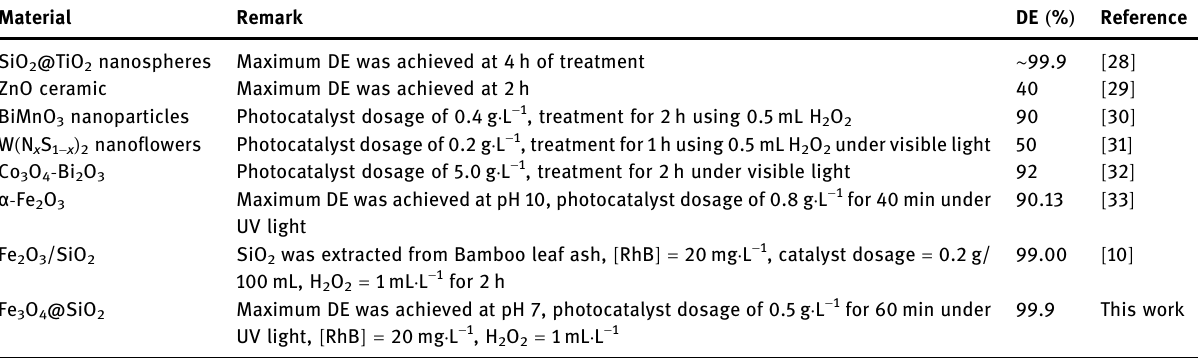
Table 6: Photocatalytic activity of Fe 3 O 4 @SiO 2 in comparison with other materials Material